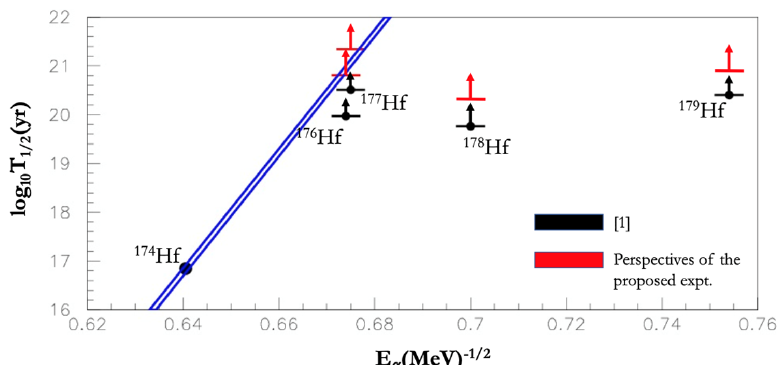
Figure 8. Diagram T 1/2 vs the inverse of the square root of alpha energy in MeV. The black symbols are the results in Refs. [1,27]. The α decay of 174 Hf has been observed [27], while only lower limits at 90% C.L. are reported for the other three Hf isotopes naturally present. The blue band is the extrapolation of the predictions for all the Hf isotopes using the Geiger-Nuttall scaling law and the observed data point [27]. The red symbols represent the sensitivity that the measurement can reach using a CHC crystal scintillator with 43.83 kg × day of exposure. As evident, there is a good perspective to observe the α decay of 176 Hf and 176 Hf (see also Table